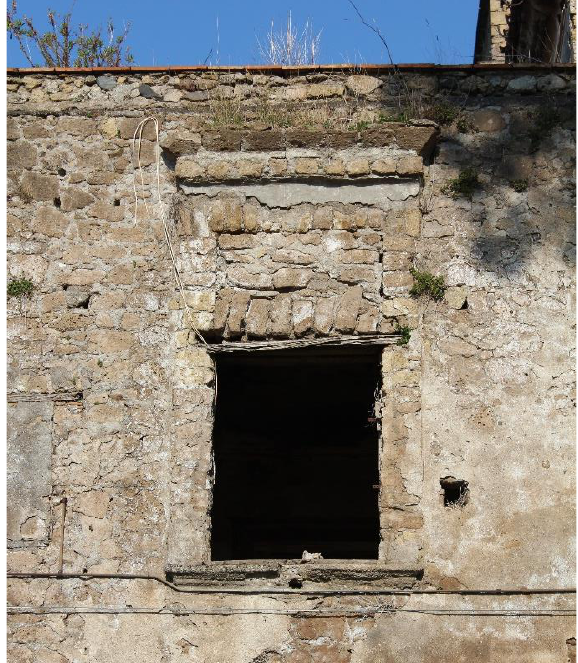
Figure 9. Detail of the south-east.